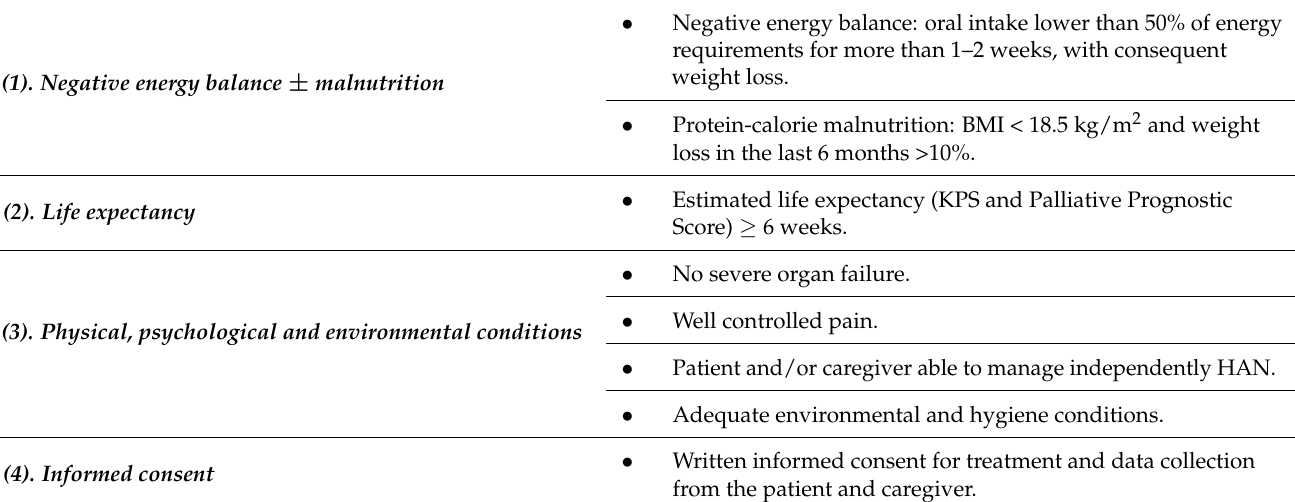
Table 1. Steps to define HAN